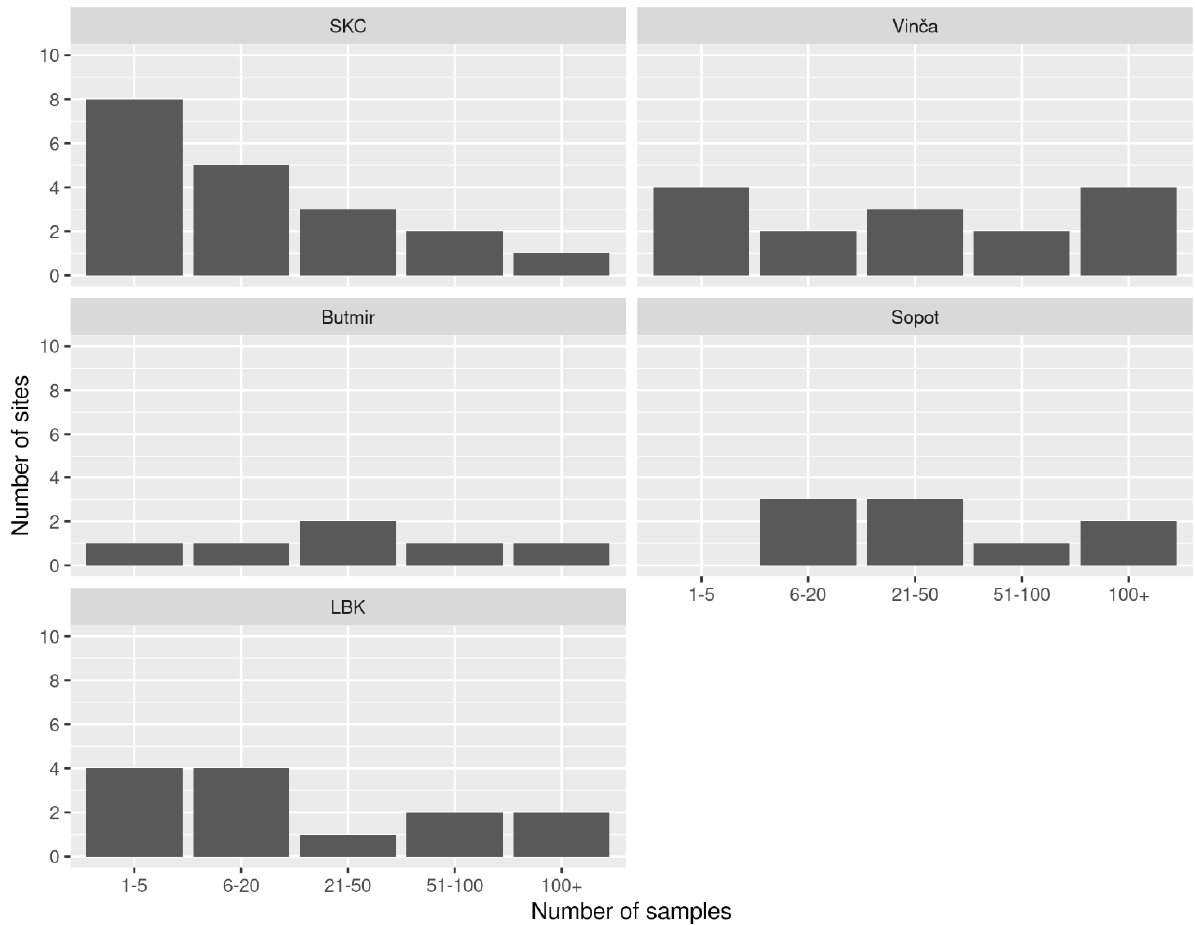
Figure 3. Correlation analysis of number (left) and volume (right) of samples to wild species assemblage richness, using log-normalised values.